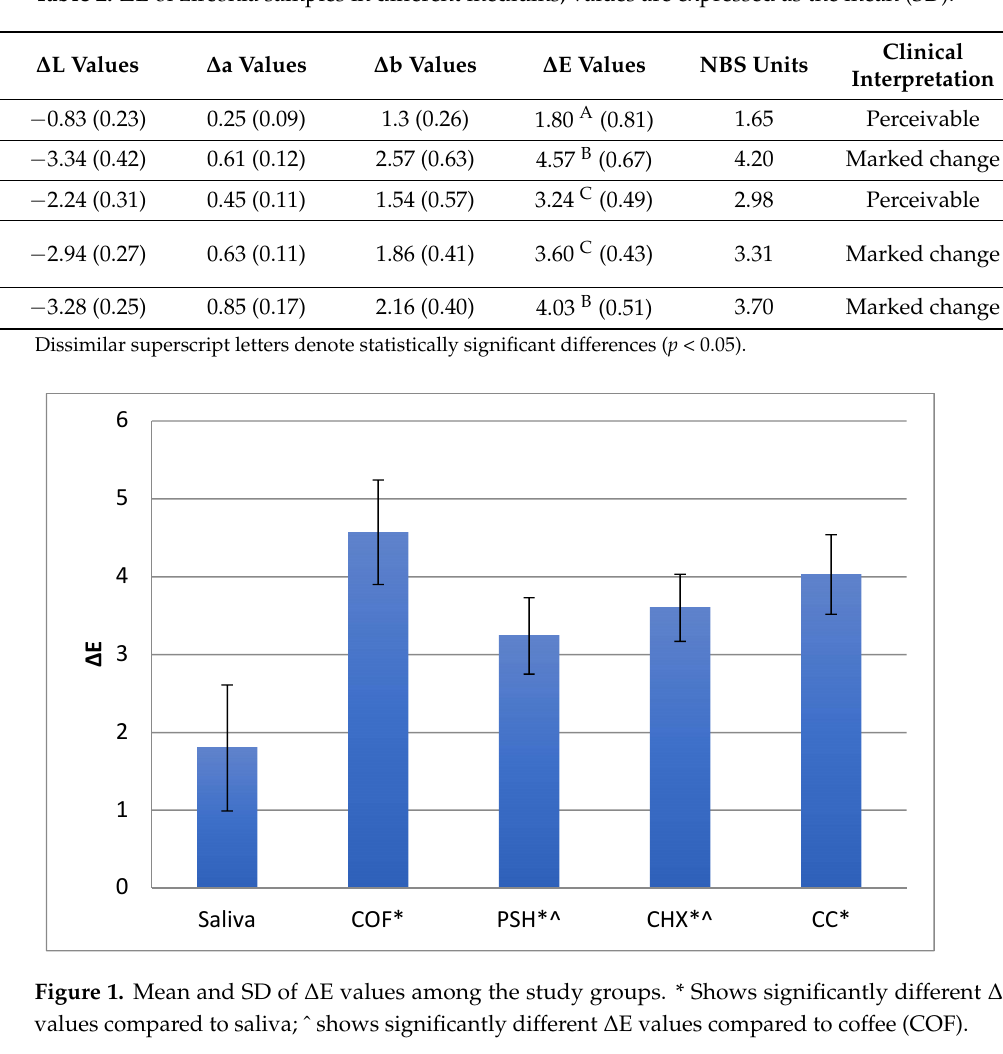
Figure 2. Mean and SD of ∆L, ∆a, and ∆b values among study groups. Concerning statistical analysis, the inter-group comparisons revealed statistically significant differences when ∆E values of gp-1 (artificial saliva) were compared with all other groups (Table 3). Significant differences were also seen when ∆E values of gp-2 (coffee) were compared with gp-3 (protein shake) and gp-4 (chlorhexidine). All other in- ter-group comparisons revealed non-significant results ( p > 0.05) (Table 3). Table 3. Statistical comparison of ∆E values among study groups (Tukey’s post hoc test). Study Groups